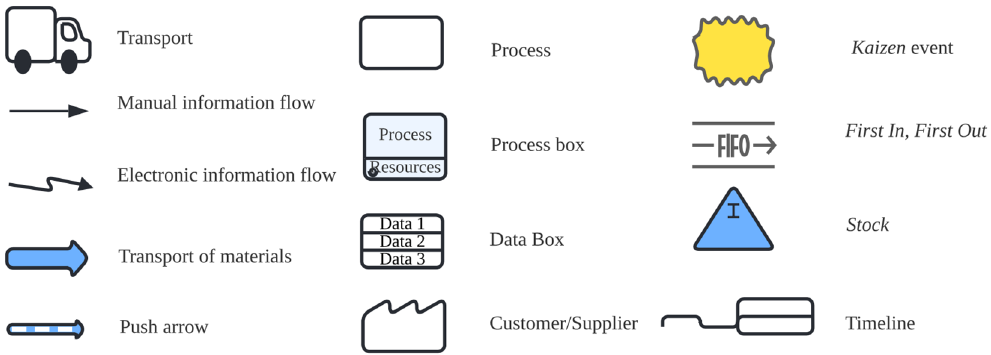
Figure 3. Symbology used in the VSM tool (Lucidchart, 2022).